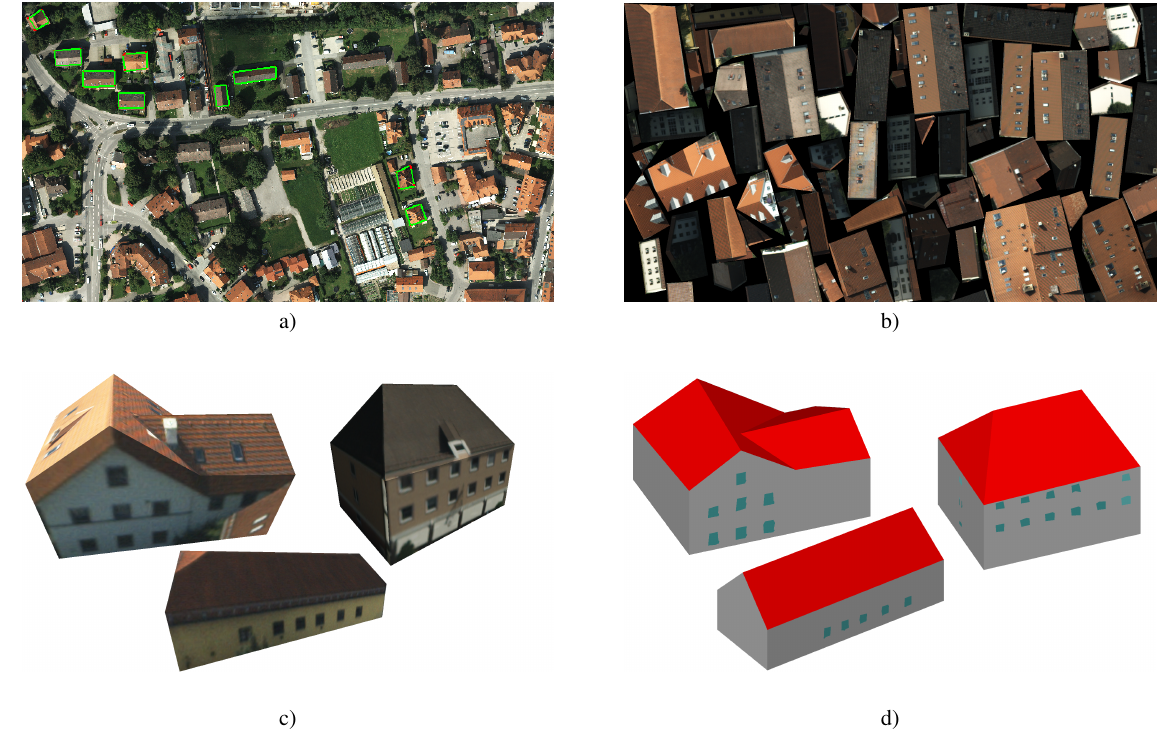
Figure 3. Results for the Murnau scene a) Contours of reconstructed buildings, b) Texture atlas, c) Textured building models, d) Same building models as CityGML showing the semantic designations of the surfaces and the windows in different